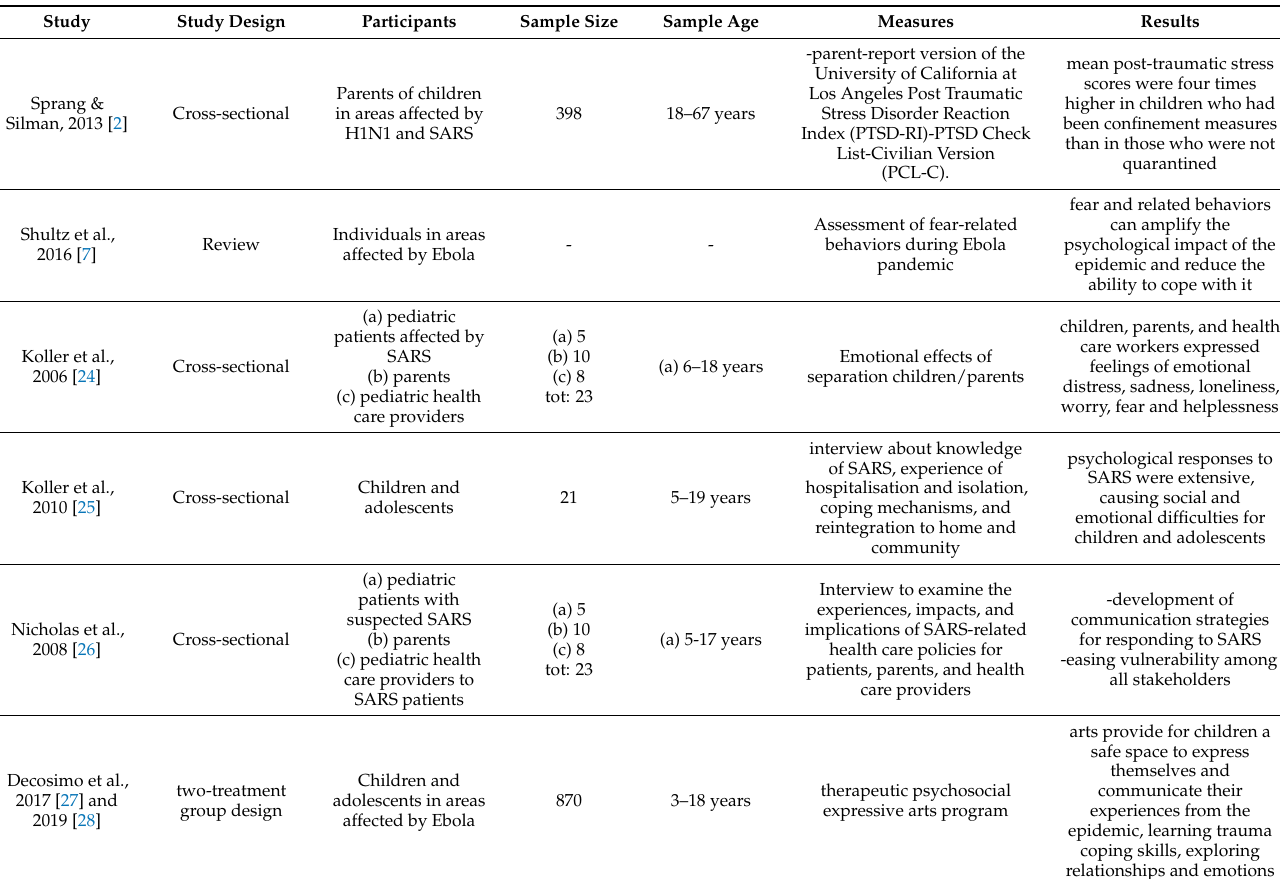
Table 1. Studies on the psychological impact on children and adolescents in pre-COVID-19 time.